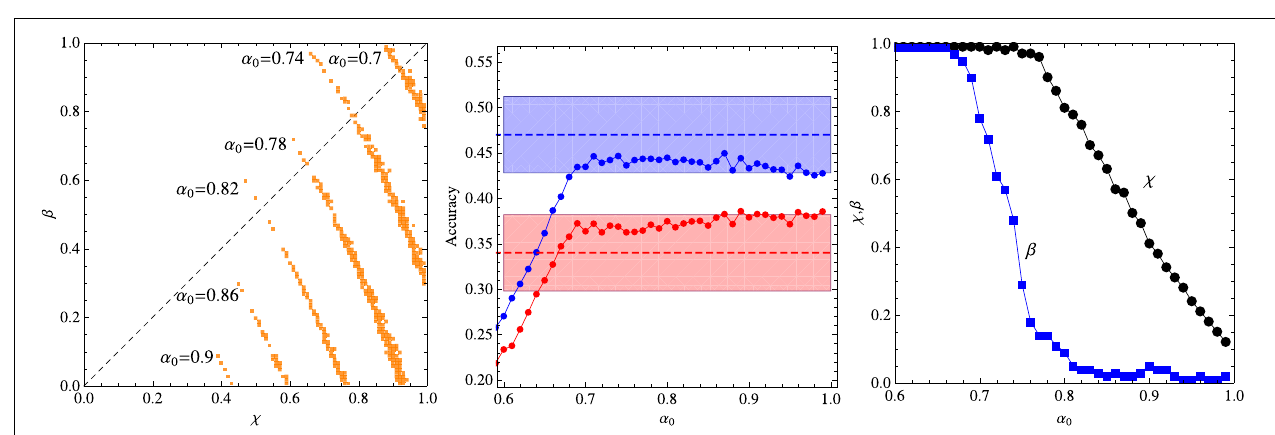
regions around them (one standard deviation). The blue symbols represent the accuracy for the group of words sampled 9 times, the green symbols for the words sampled 6 times, and the red symbols for the words sampled 3 times. Right panel: Parameters χ and β corresponding to the best fit shown in the middle panel. The other parameters are N = 18 and C = 4.